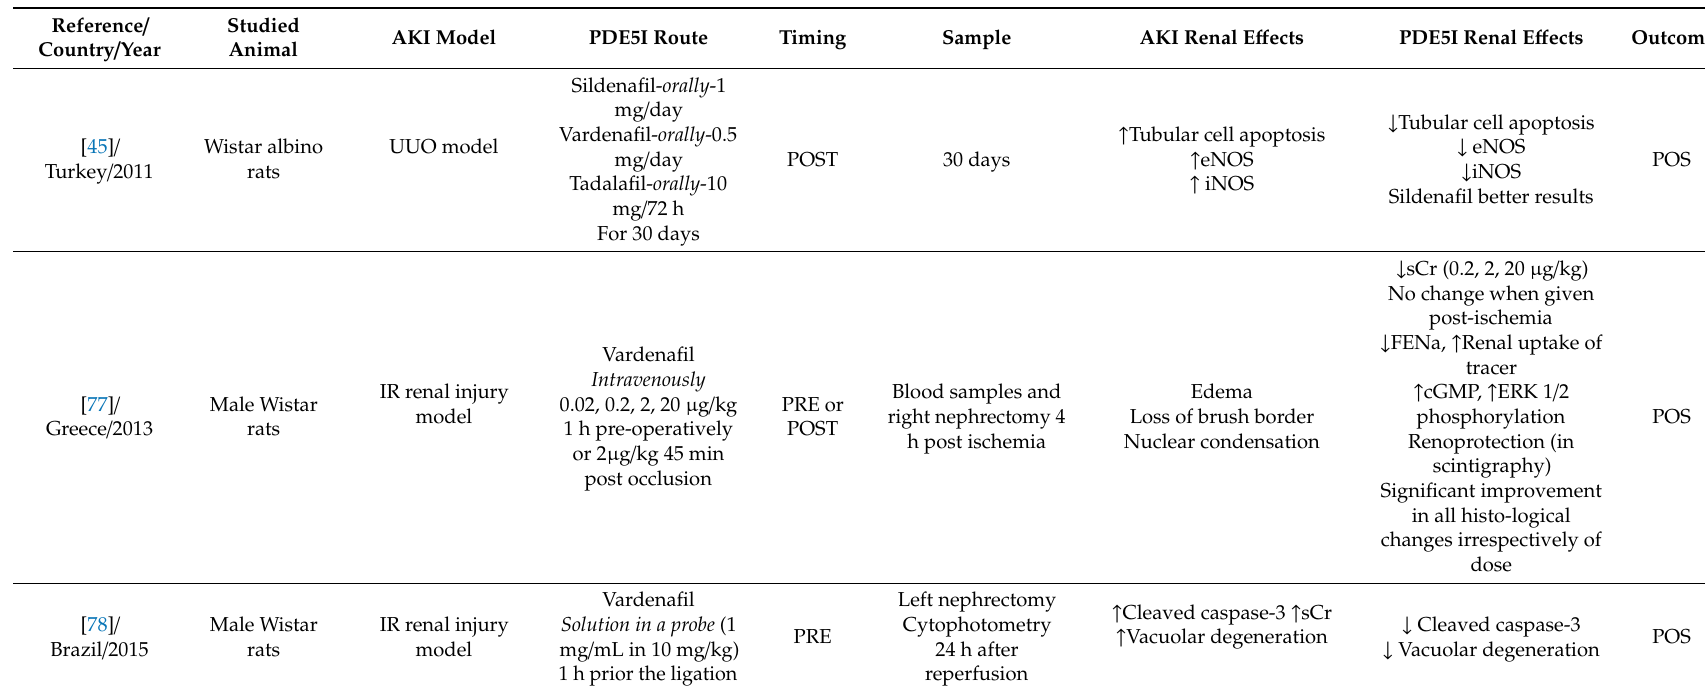
Table 5. Animal studies evaluating the potential reno-protective e ff ects of